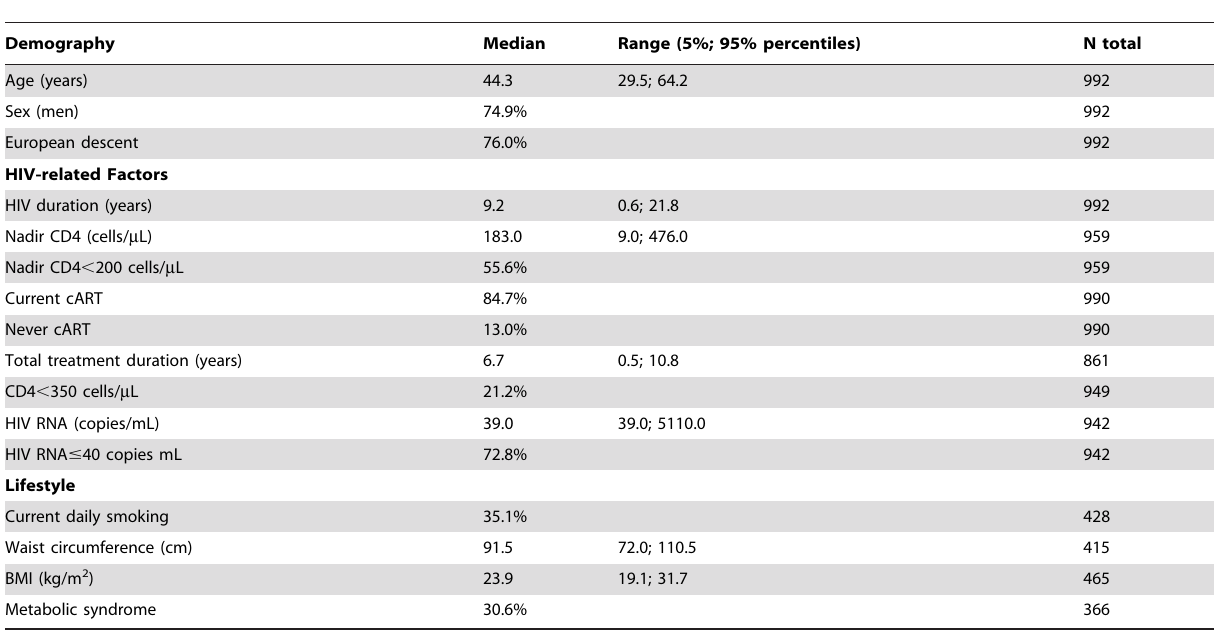
Table 1. Baseline characteristics for HIV-infected patients not infected through intravenous drug use (IDU).